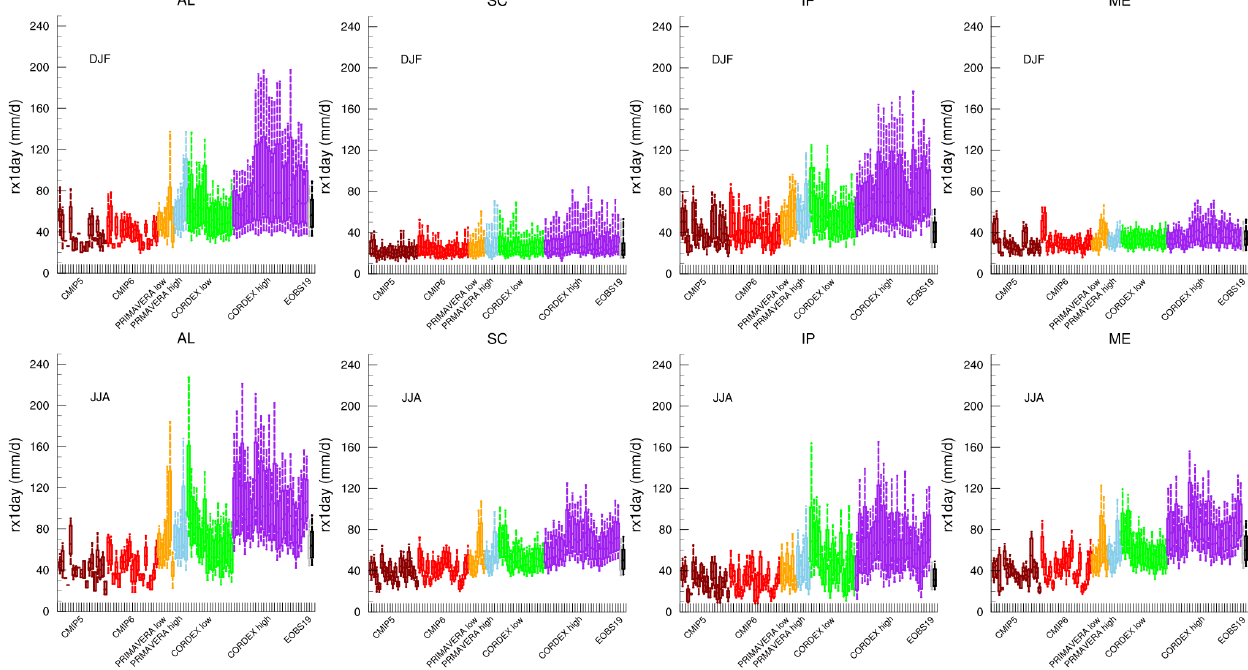
Figure 10. Same as Fig. 6 but for the maximum 1d precipitation (Rx1day, mmd − 1 ): top row: winter (DJF); bottom row: summer